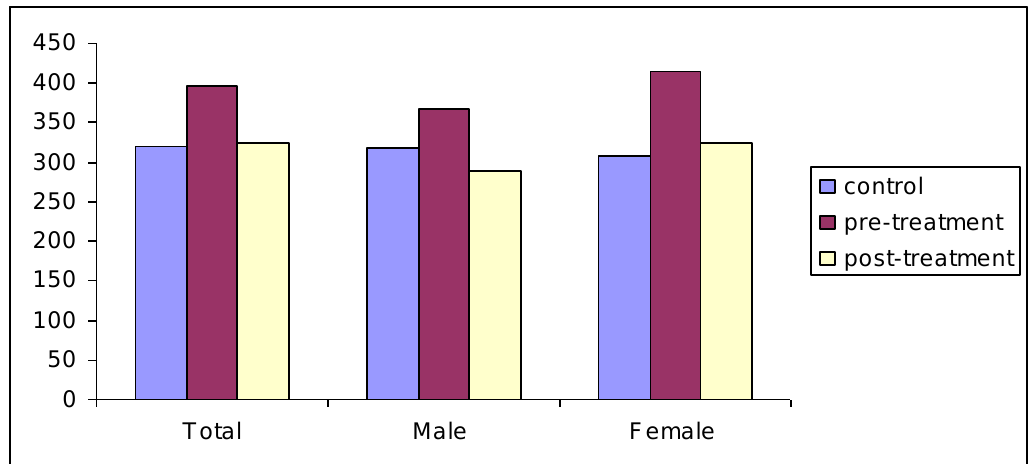
Figure (3): The level of serum complement four at baseline and one month later of using chloroquine